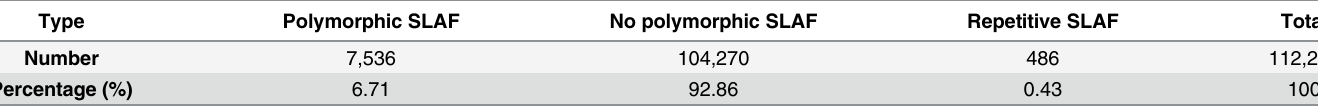
Table 3. Statistical results for each SLAF type.